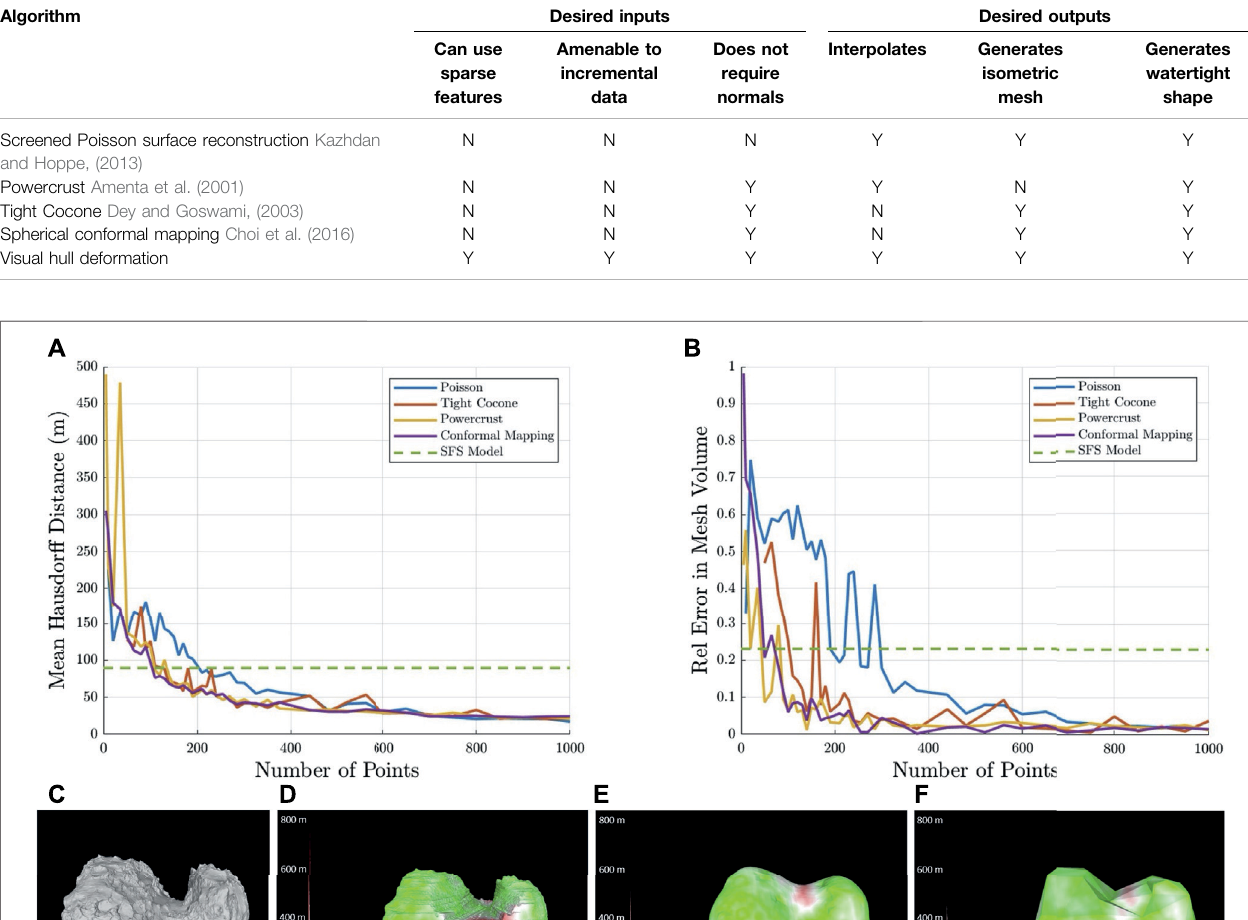
TABLE 2 | Summary of coarse 3D mapping methods.